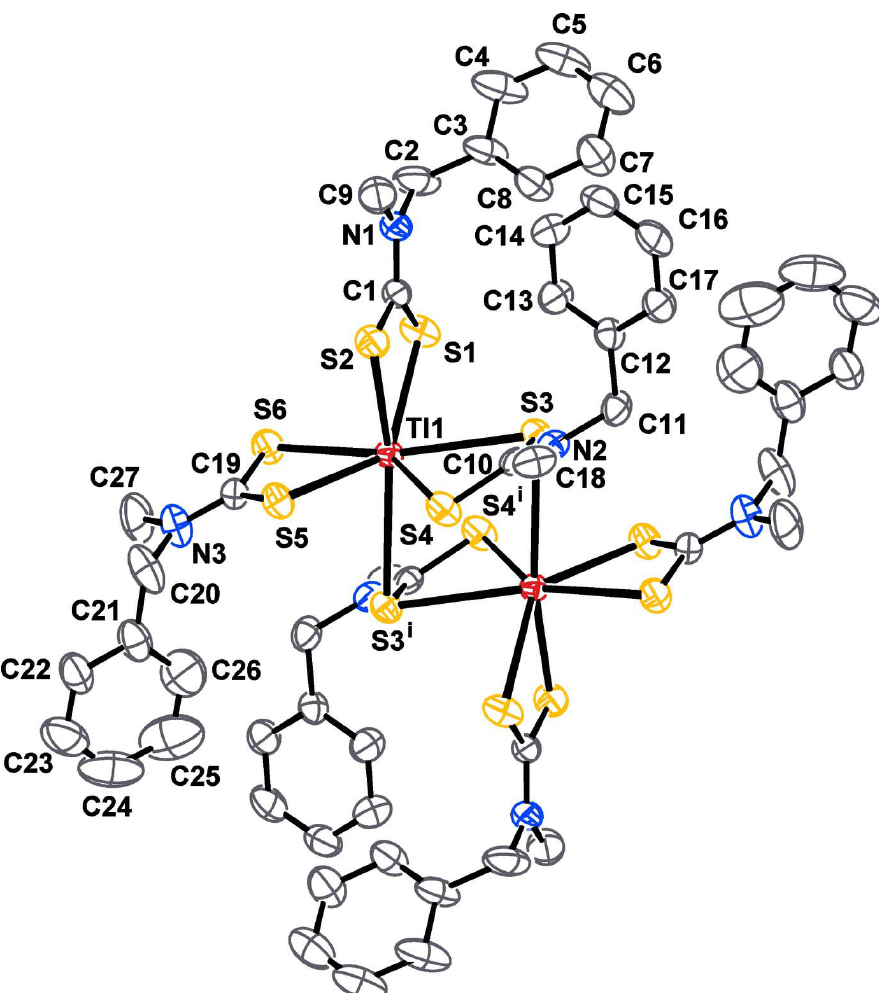
Figure 1 View of the title dinuclear complex molecule with displacement ellipsoids drawn at the 30% probability level. Hydrogen atoms are omitted for clarity [Symmetry code: (i) = 1 - x , - y , - z